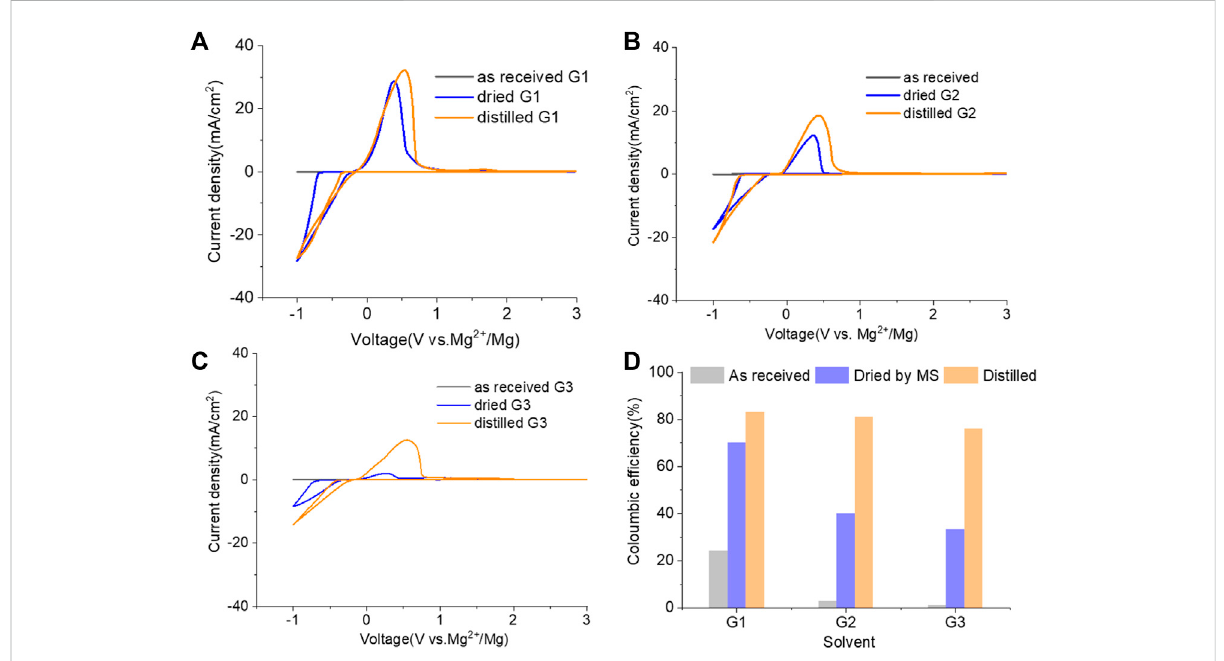
FIGURE 4 Cyclic voltammograms (CVs) for the electrolytes in (A) G1, (B) G2, (C) G3, and (D) Coulombic ef fi ciency for each solvent (dried by molecular sieves, distilled) containing 0.25 M MgTFIS 2 and 0.25 M MgCl 2 . Pt was used as the working electrode, and the scan rate was 25 mV s − 1